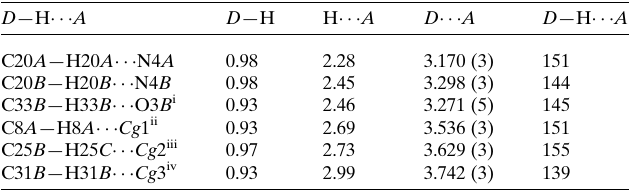
Table 2 Experimental details. Crystal data Chemical formula